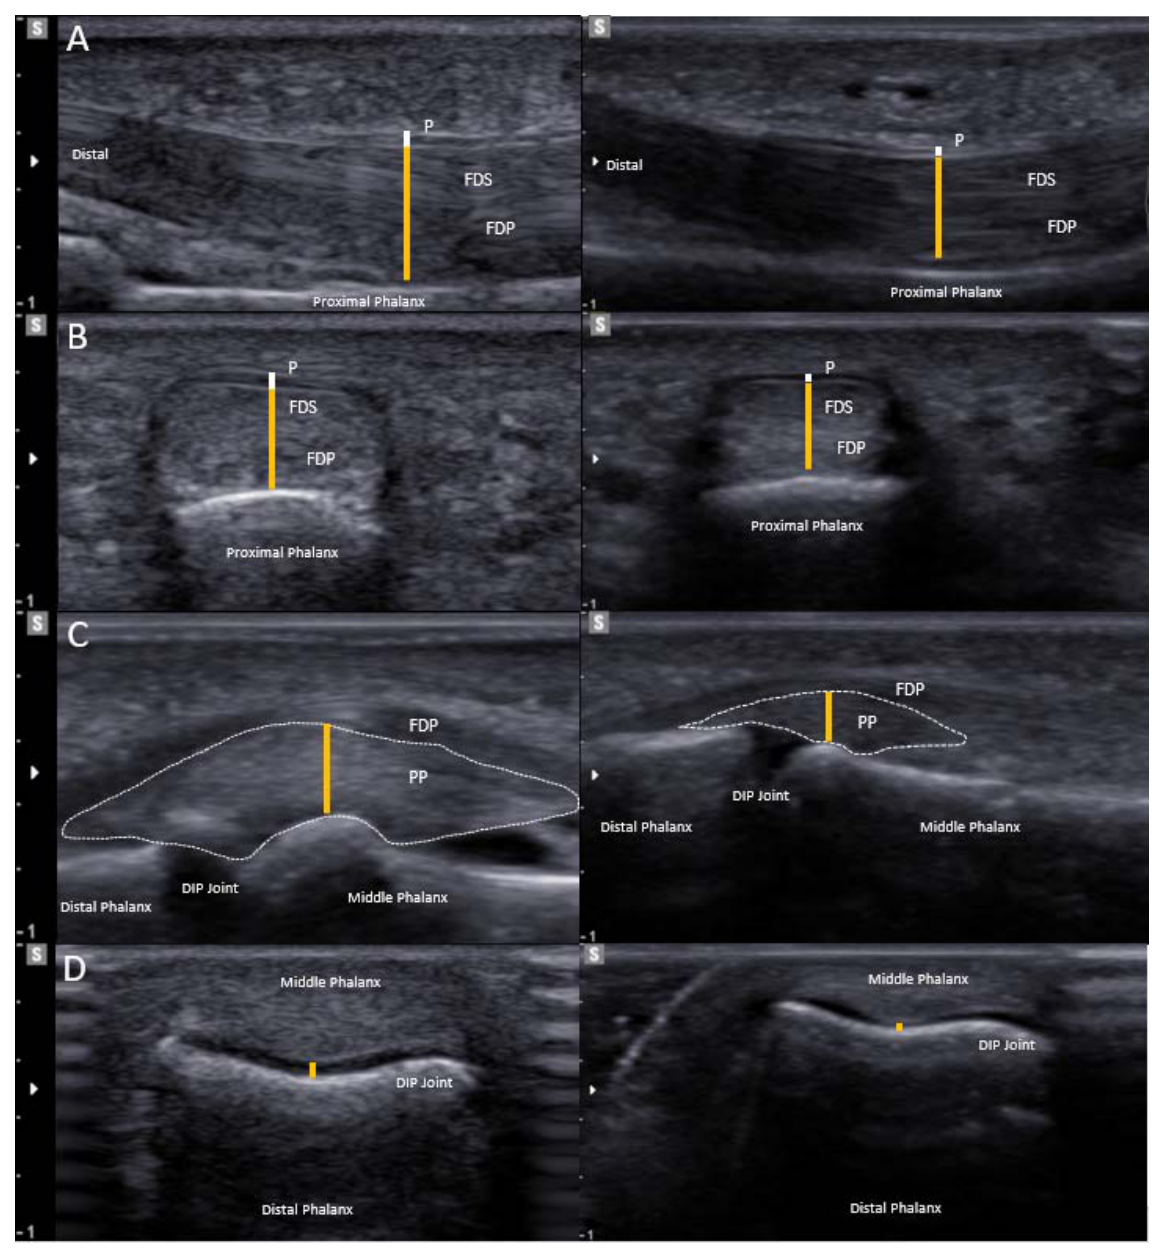
Figure 3. Ultrasound examination. Left: participant; Right: height- and weight-matched non- climbing male: ( A ): Longitudinal view of flexor tendons (FDS and FDP) at their stoutest point under the A2 pulley (P). ( B ): Axial view of A2 pulley (P) and the flexor tendons (FDS and FDP). Note the thicker flexor tendons (orange line) and the thicker pulley (white line) in the elite climber. ( C ): Sagittal view of the palmar plate (PP) (marked with dotted line) of a DIP joint. Note the thicker palmar plate (orange line) in the climber. ( D ): Transverse plane of the DIP joint. Note the thicker cartilage (orange line) in the climber.